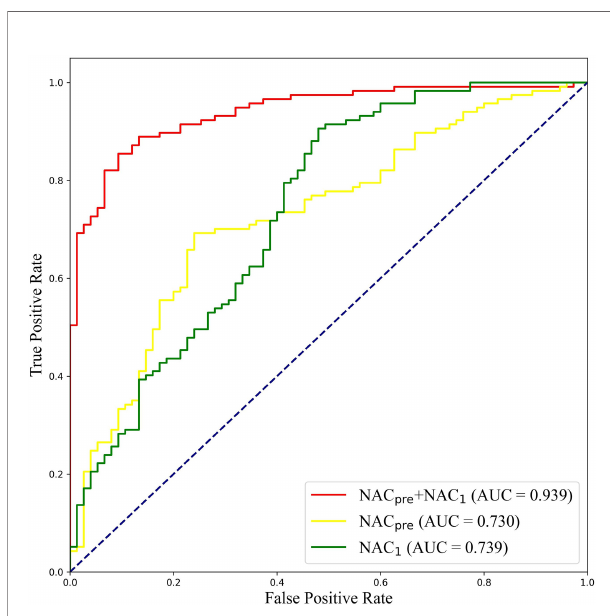
FIGURE 8 | ROC curves of DBNN using data from different chemotherapy